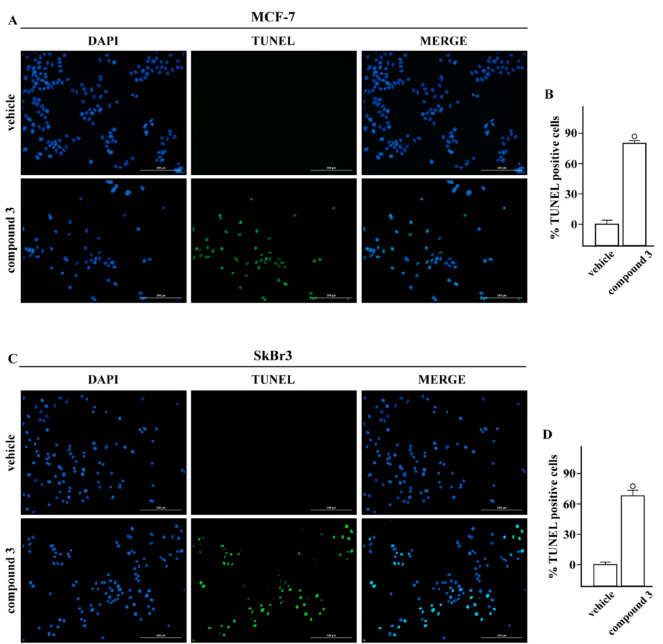
Figure 3. TUNEL assay. Compound 3 induces apoptotic cell death. TUNEL staining (green) in MCF-7 ( A ) and SkBr3 ( C ) cells treated for 24 h with vehicle or 10 µ M 3 (compound 3), as indicated. Nuclei were stained by DAPI (blue). Each experiment shown is representative of 20 random fields observed. ( B , D ) Percentages of TUNEL-positive cells over vehicle-treated cells, ( ◦ ) indicates p < 0.05 for cells receiving vehicle versus treatments. Scale bar 200 µ